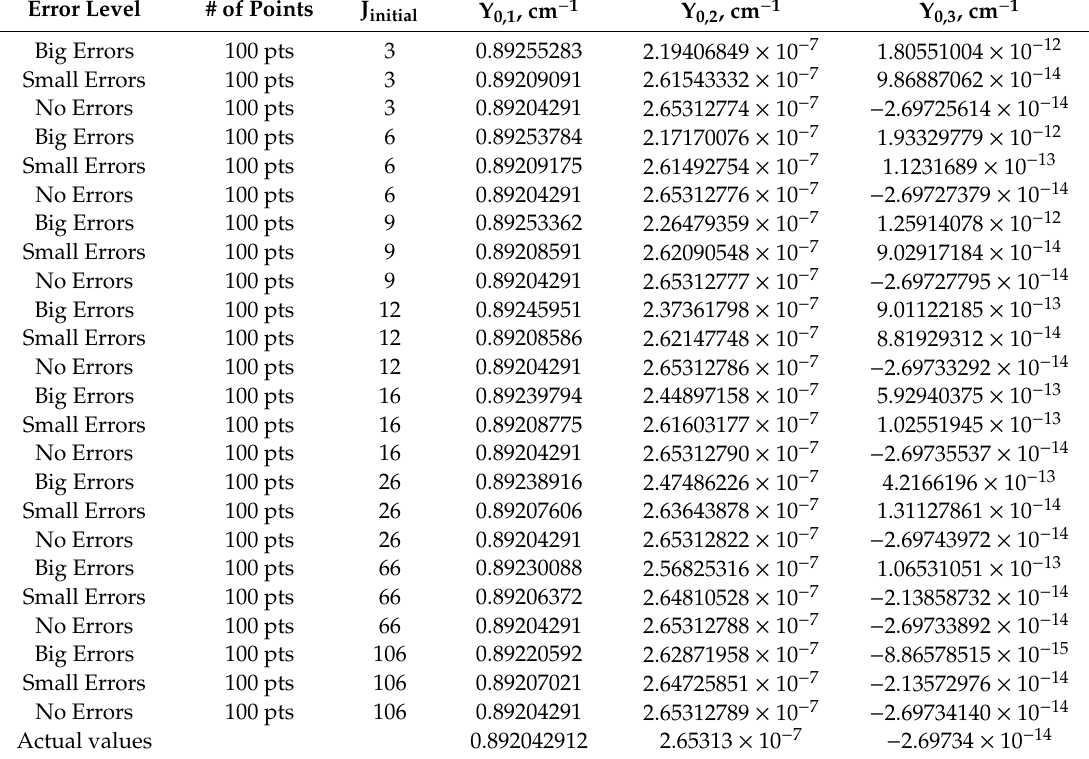
Table 1. Results from the second test, after increasing the size of the Dunham coe ffi cients and the number of experimental points (see text in the preceding paragraph). The starting J values were 3, 6, 9, 12, 16, 26, 66, and 106, and the actual Dunham coe ffi cients are shown at the bottom of the